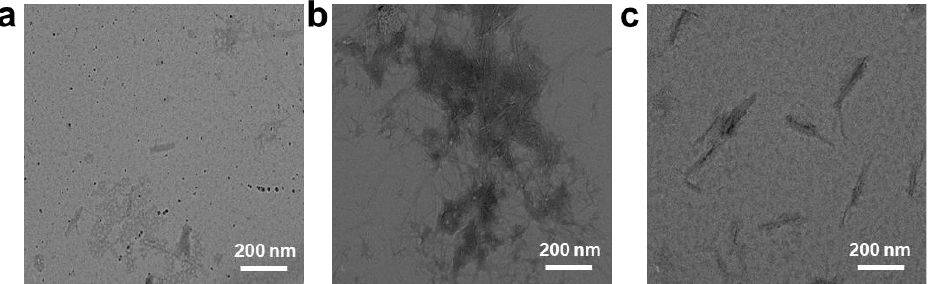
Figure 5. TEM images of ( a ) A β 1 – 42 peptide at 0 h, ( b ) A β 1 – 42 peptide incubated for 24 h, and (c) A β 1 – 42 peptide incubated with 6 mg/mL N-CDs for 24